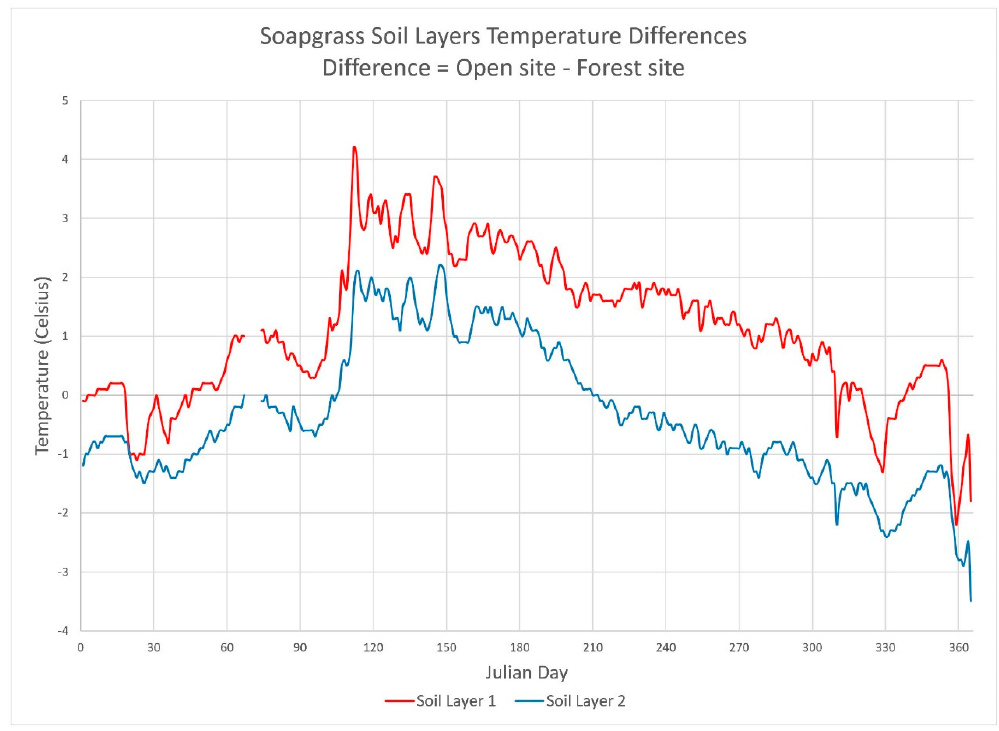
Figure 1. Daily differences in soil temperature (°C) between open (clear-cut) and forest sites at the O’CCMon Soapgrass site. Temperature differences were calculated as the Open Site temperature minus the forest site temperature at each Julian day during the year 2005. Thus, positive values denote days where the open site soil temperature was warmer than the forest site soil temperature. Open minus forest soil temperature differences were calculated for each of the two soil depths, 15 cm (red line) and 30 cm (blue line) below the soil surface. The data gap between Julian days 67 and 74 was due to sensor